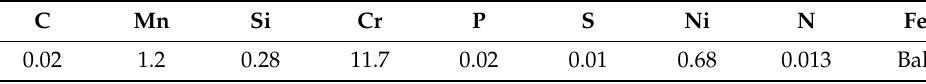
Table 1. Composition of experimental steel